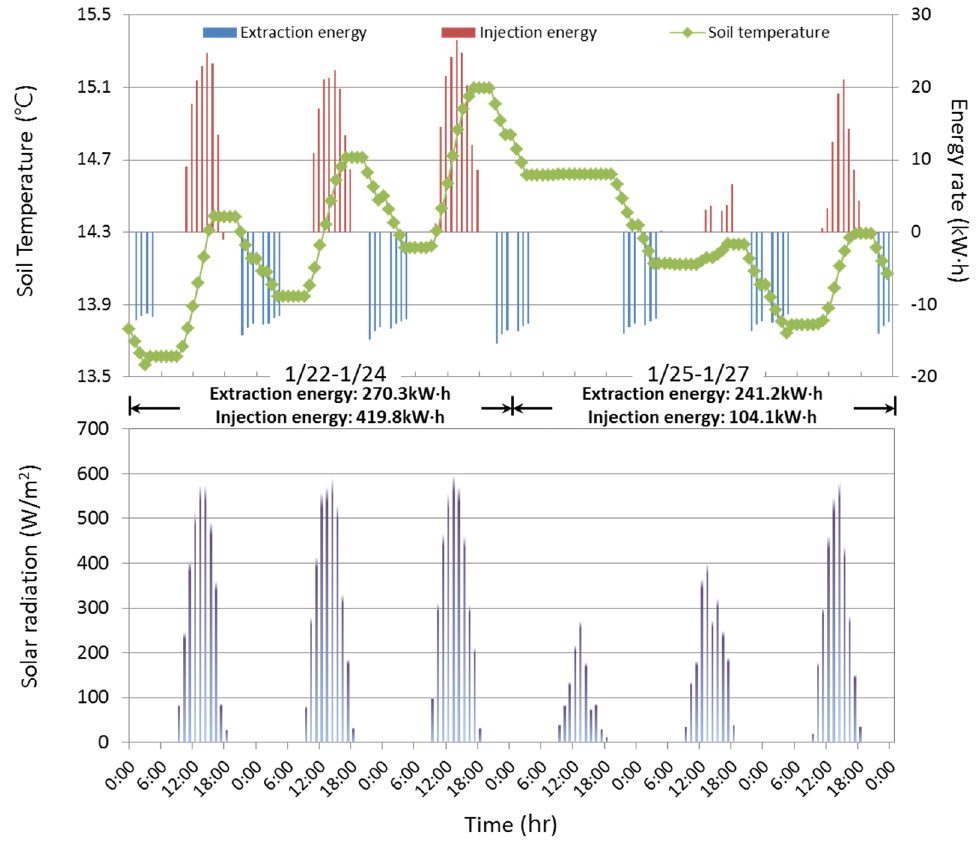
Figure 6. Simulation result of SAGHPS.